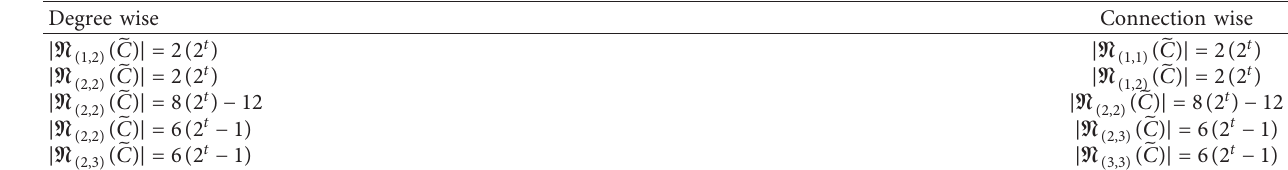
Table 1: Total amount of edges on degree and connection